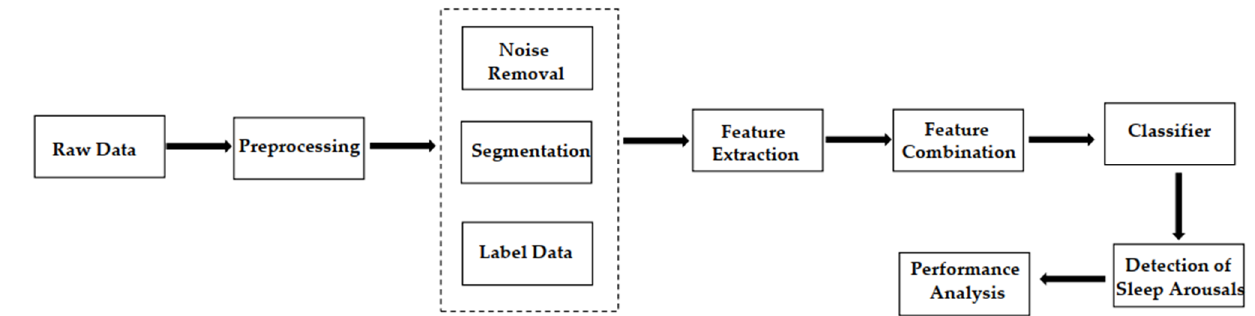
Figure 5. General workflow of sleep arousal detection models with machine learning.